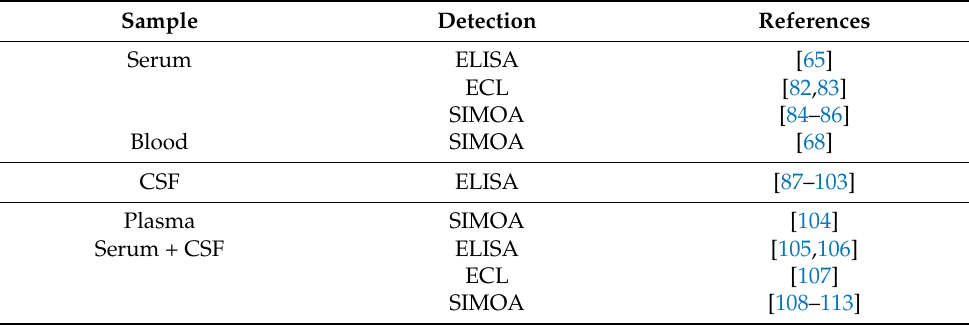
Table 1. Neurofilament light is detected in various types of MS patient samples. Neurofilament light is detected in various types of human samples. The detection methods use a variety of assays as indicated, including ELISA, ECL, and SIMOA